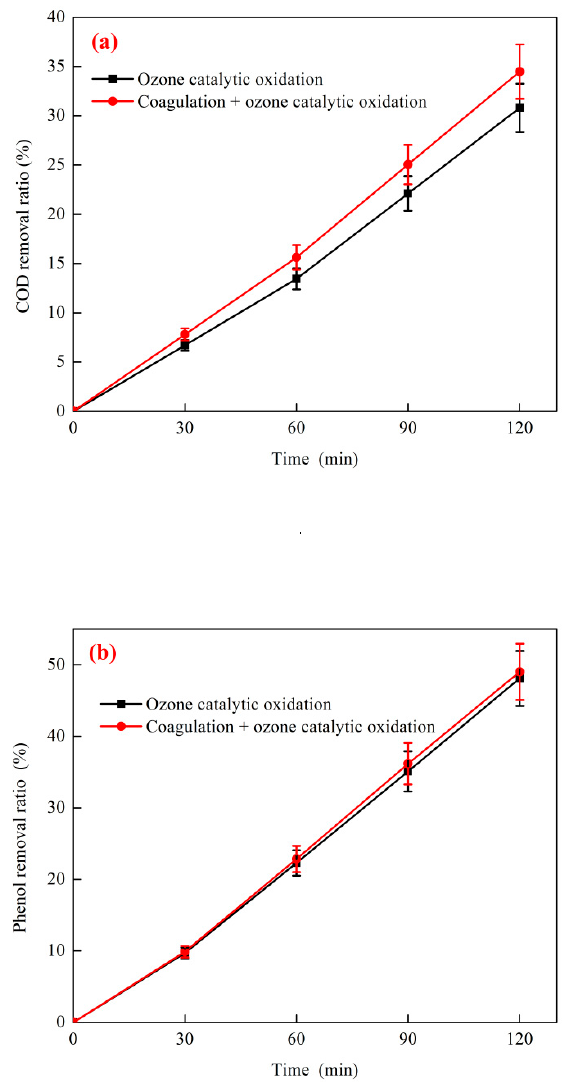
Figure 9. Effect of coagulation on the treatment of coking wastewater by combination process of coagulation + ozone catalytic oxidation: (a) COD removal and (b) phenol removal.